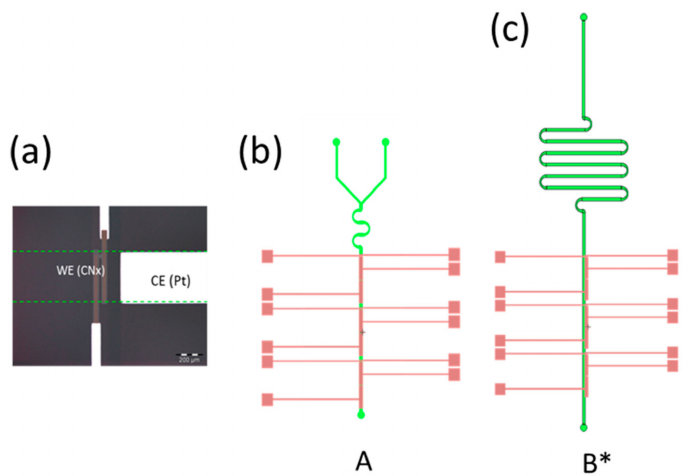
Figure A3. Photography and L-Edit channel and microelectrodes geometries. ( a ) Microscopic view of the working microelectrodes in amorphous nitride carbon (WE) on top of the counter electrode (CE) in platinum. ( b ) Fluidic channel with geometry A. ( c ) Fluidic channel with geometry B*. See dimensions on enlarged zone WE/CE electrode pair (Figure 2c,d) where WE stands for a -CNx working electrode (width, w = 300 µ m, length, x e = 30 µ m), CE stands for platinum counter electrode (w = 300 µ m, x e = 2 mm) and the fluidic channel height and width are equal to 40 µ m and 300 µ m, respectively. Note that here channel and electrode widths are the same. The total effective volume of the sample depends on the microchannel volume (detection zone area, which is the same on A and B* configuration) is approximately equal to 0.24 µ L covering the electrode